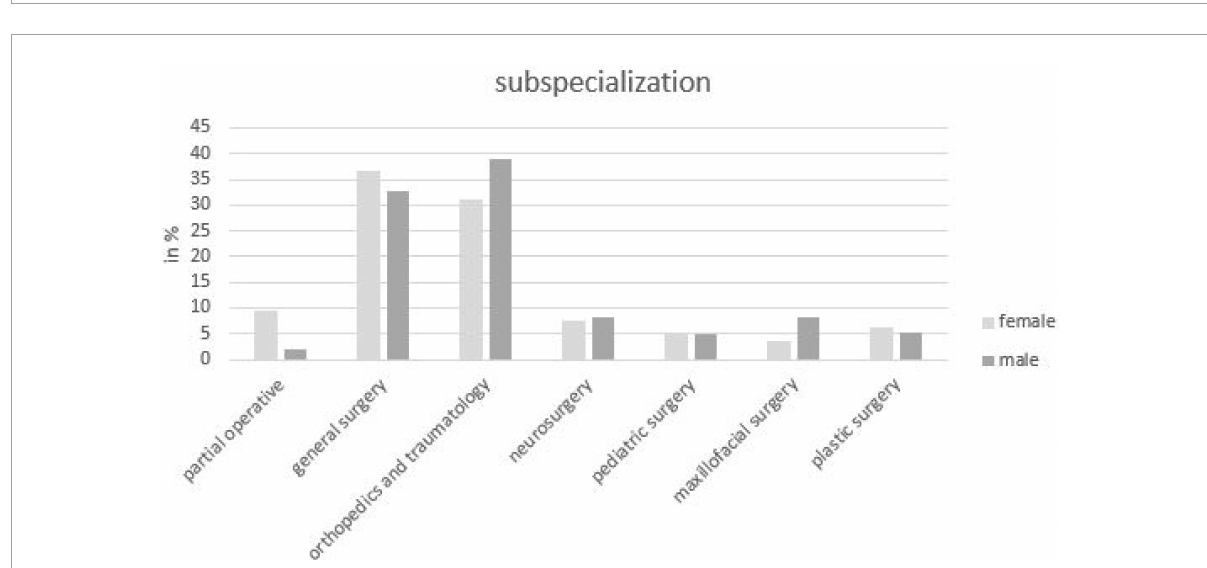
FIGURE3 Distribution of the sexes in the surgical subjects in percent (absolute numbers) of all students, which want to choose a surgical subject area ( n =